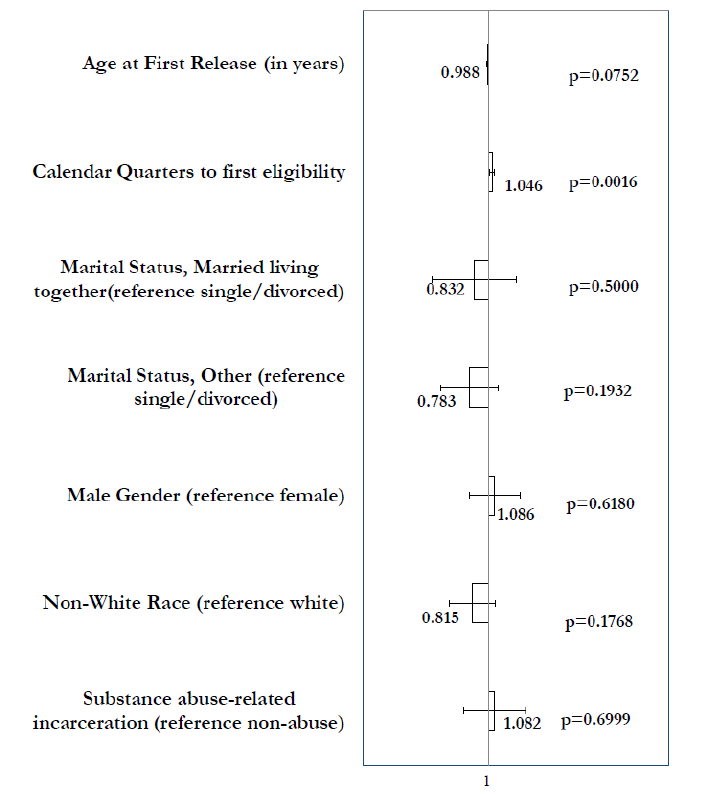
Figure 4. Three-year Survival Analysis Hazard Ratios and 95% Confidence Intervals for Eligibility at Re-incarceration (Eligibility Measure